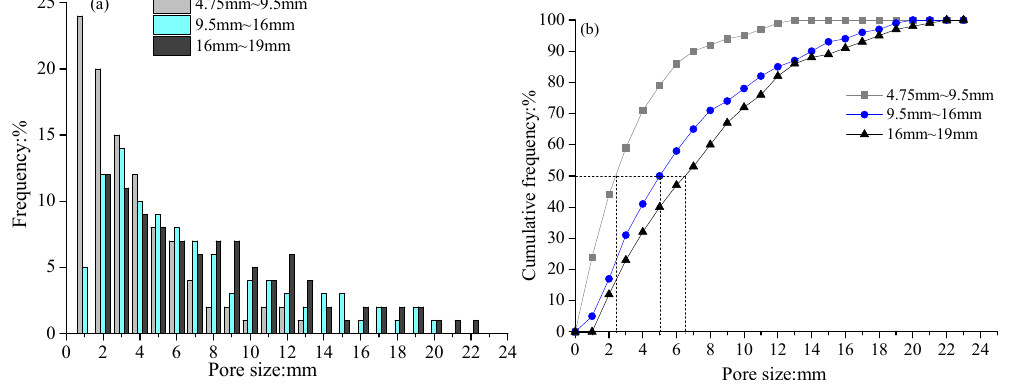
Figure 6. Effect of a single-size aggregate on the pore distribution of pervious concrete. ( a ) Frequency distribution of pore sizes; ( b ) cumulative frequency distribution of pore sizes. The design porosity was 15%. The figure shows the average value of three to five specimens.